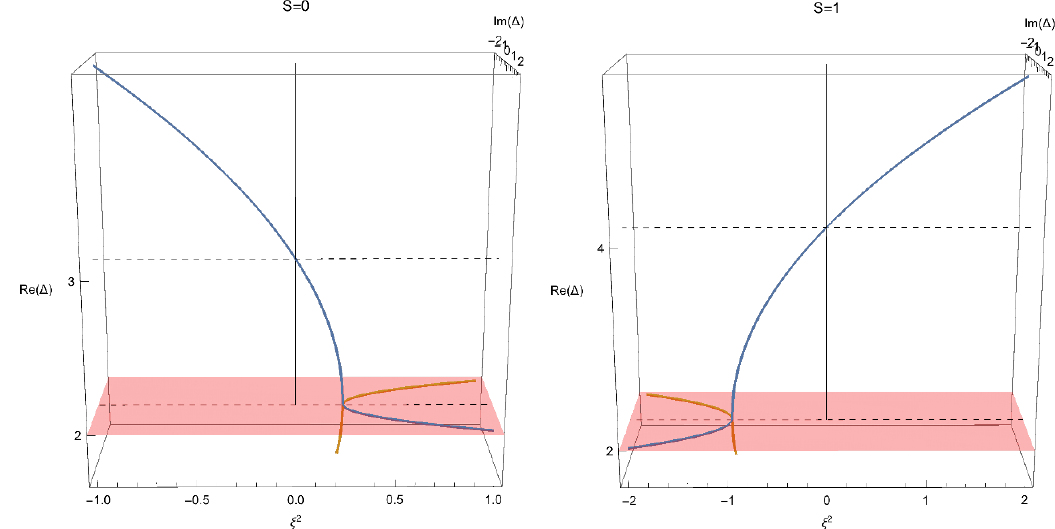
Figure 9 . Dependence of ∆ 1 on the coupling constant ξ 2 for S = 0 (left) and S = 1 (right). At 1) S ( S +1) 2 / 4 the function ∆ 1 approaches the value weak coupling ∆ 1 = 3+ S + O ( ξ 2 ). For ξ 2 = ( − ∆ = 2 and, then, continues into the complex plane Re ∆ = 2 after the collision with the shadow level 4 ∆ 1 −